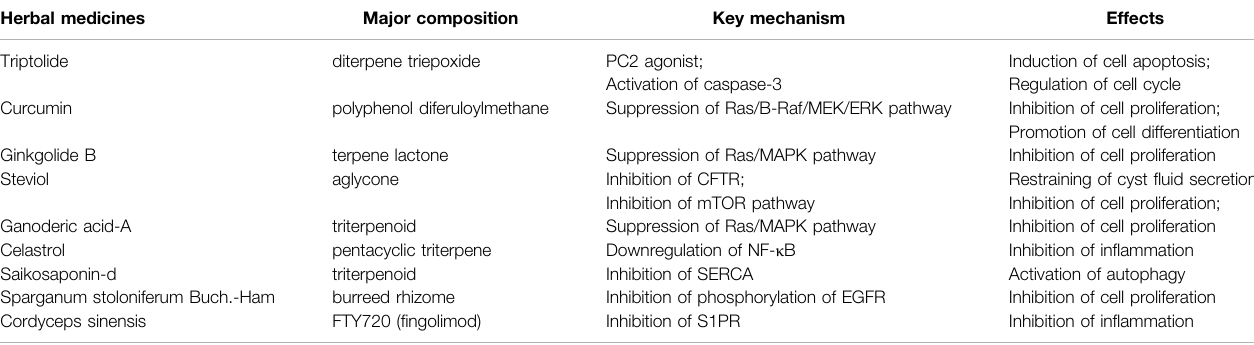
TABLE 1 | Underlying possible mechanisms of herbal medicine in